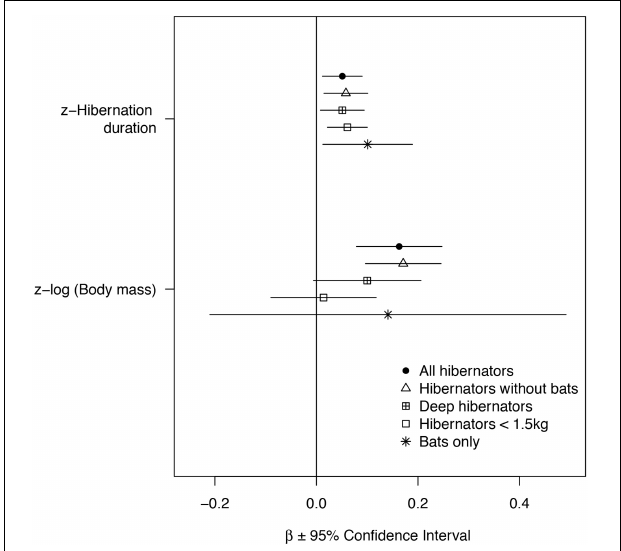
FIGURE 1 | Effects of hibernation season duration and body mass on longevity. Z-standardized model coefficients are presented ± 95% Confidence Interval (1.96xSE). Both body mass and longevity were log-transformed before the analyses. The effect sizes are presented for PGLS models for all mammals ( N = 82), mammals without bats ( N = 55), deep hibernators without bats ( n = 46) and small mammals without bats ( N = 44). For comparison, effect sizes from a simple linear model not accounting for phylogeny are presented for bats only ( N =